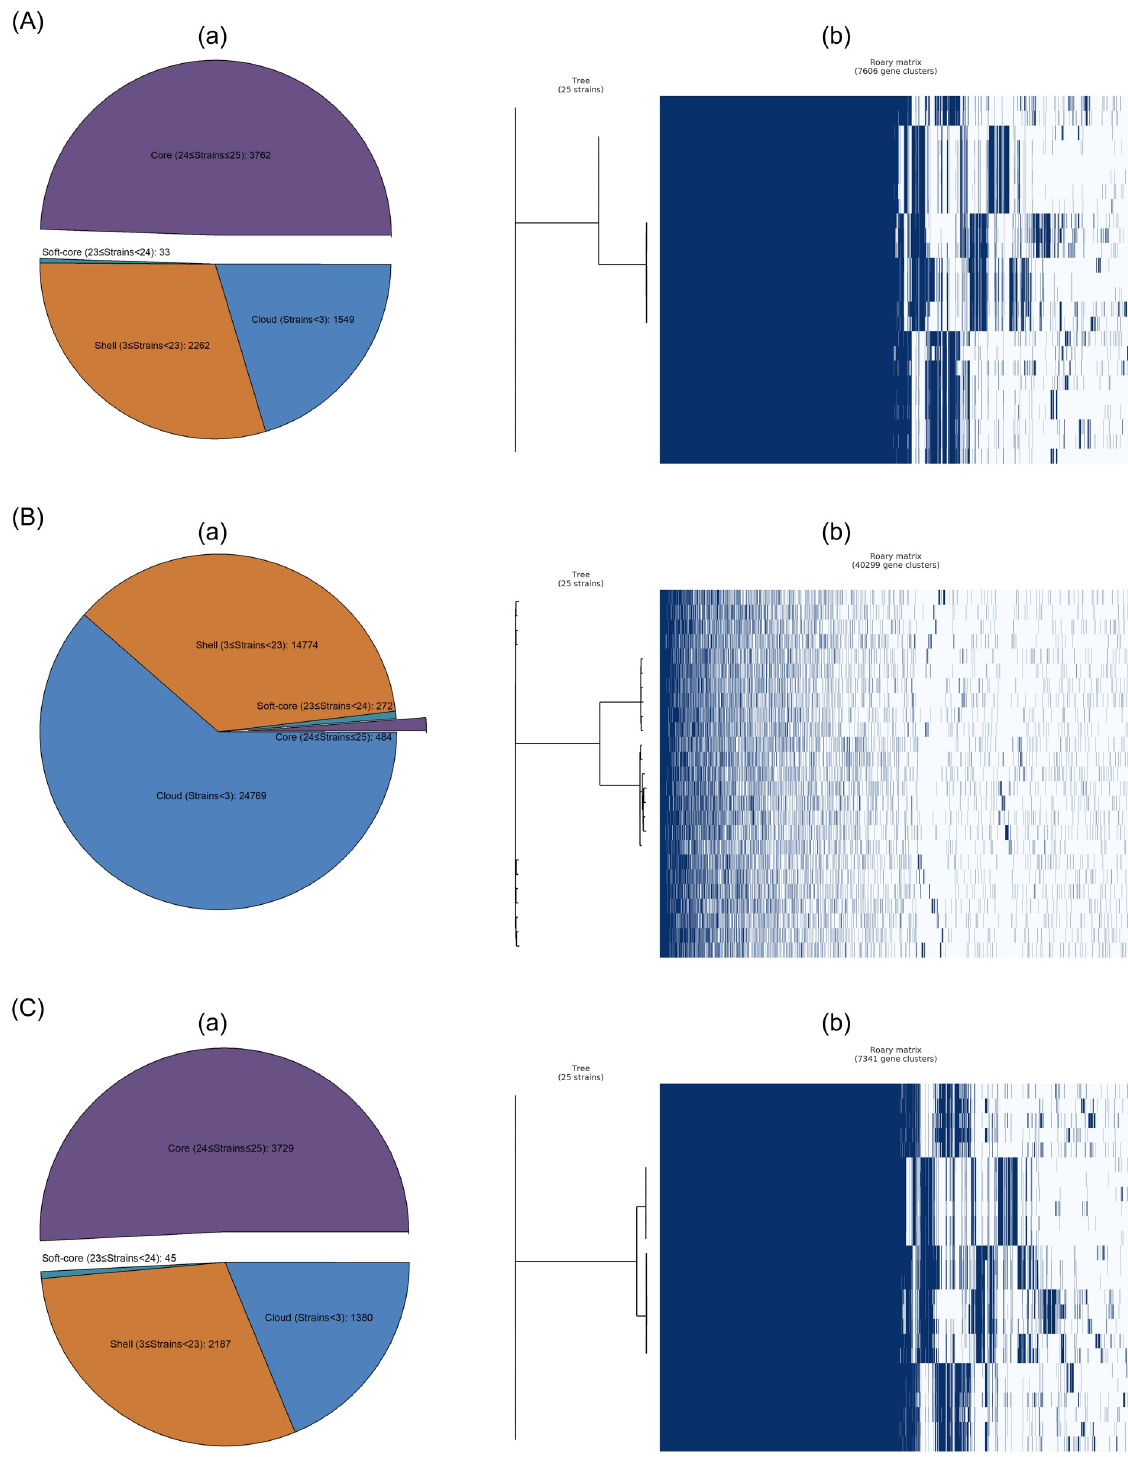
Fig 4. Pan-genome compositions (a), and core-genome phylogenetic trees compared to matrices with the presence and absence of core and accessory genes (b) of Salmonella isolates based on their hybrid (A), MinION (B), and MiSeq (C) assemblies.